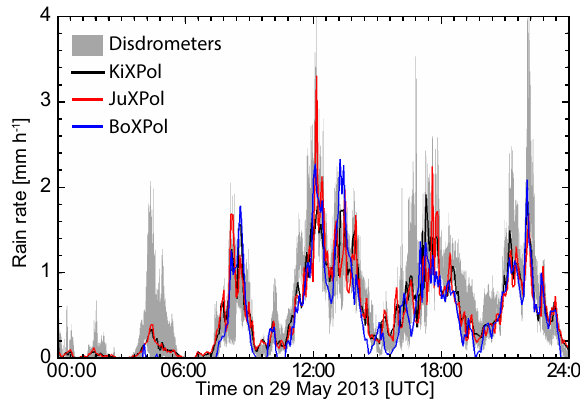
Figure 14. Time series of rain rates derived from observations of seven disdrometers (including those from the TR32 programme) and the three polarimetric radars on 29 May 2013. The shaded grey area indicates the range of rain rates observed by the disdrometers with 1 min temporal resolution in the HOPE area, while the rain rate from the three polarimetric radar observations is calculated at the radar gates that are coincident with disdrometer locations and also averaged over the disdrometer locations. From Xie et al.